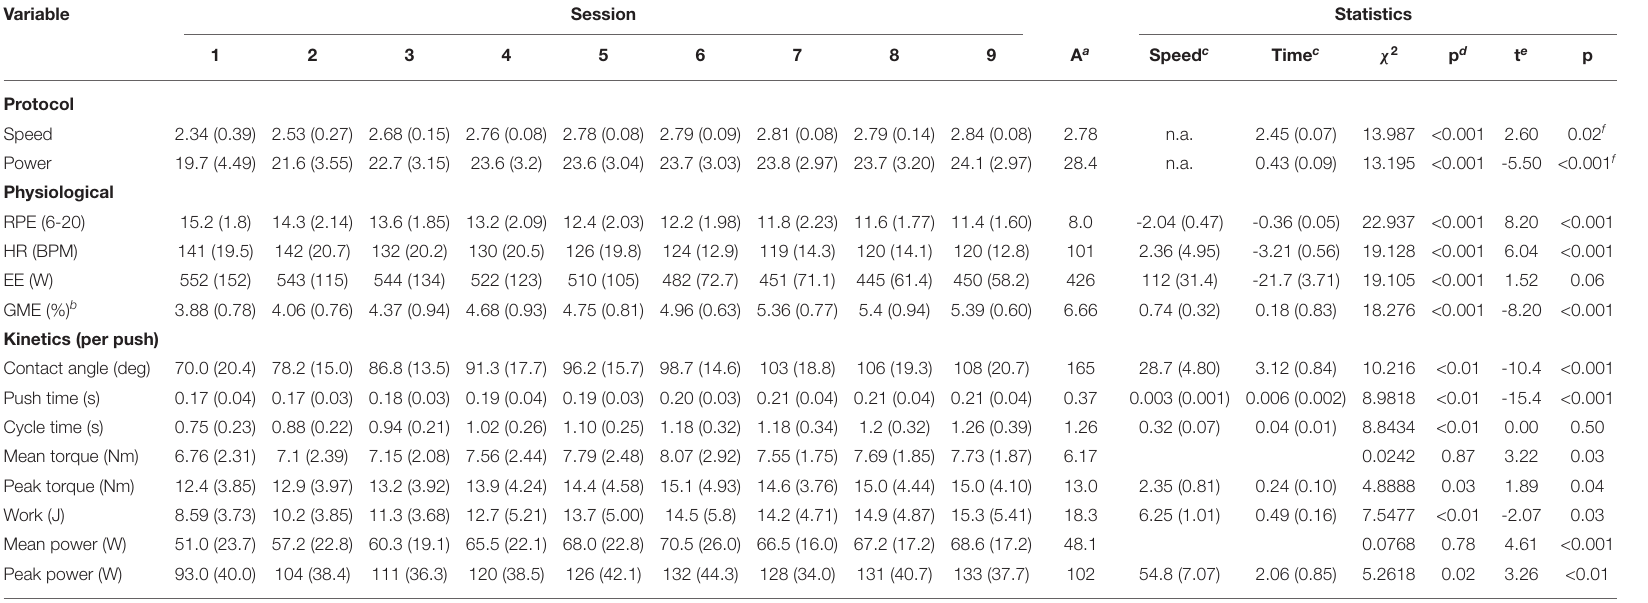
TABLE 1 | Outcomes: last minute of each block aggregated by session and reference data of a single wheelchair athlete with mixed effects regression and one-sample t -test results (n=15). Variable Session